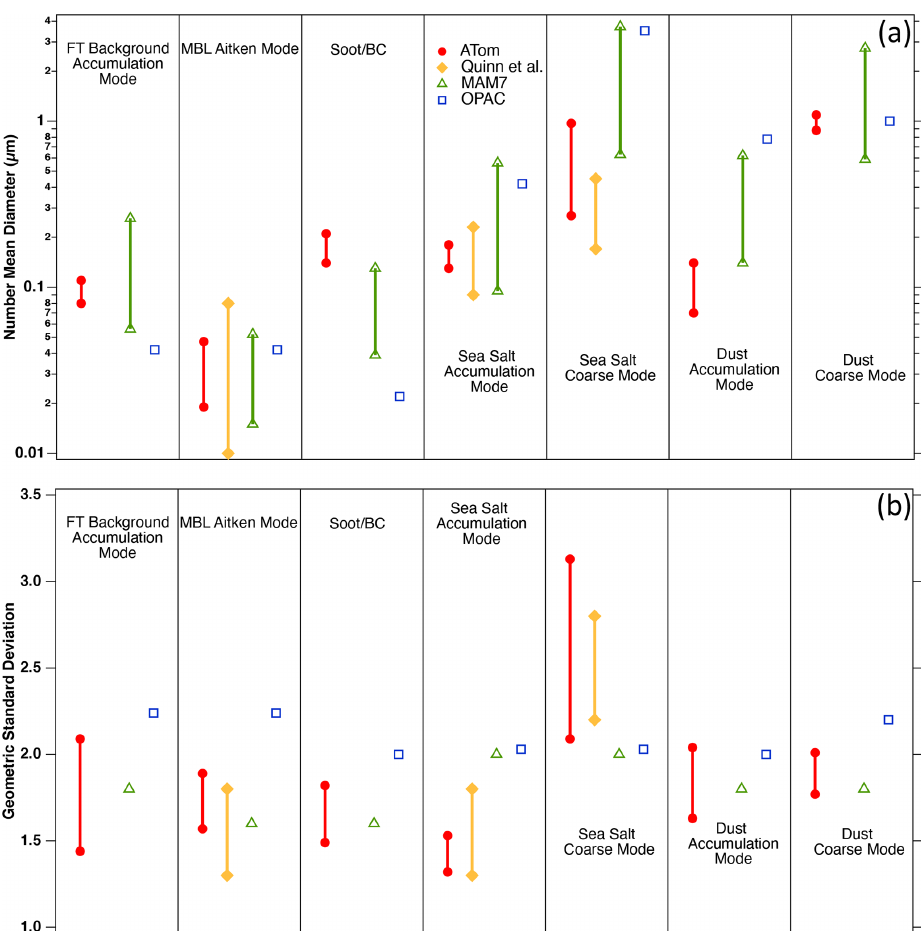
Figure 15. Lognormal parameters for different aerosol types from fits to the ATom dataset (showing interquartile range), from fits to shipboard size distribution measurements on the remote oceans (Quinn et al., 2017, showing full range), from the MAM7 modal aerosol model (Liu et al., 2012, 2016, showing interdecile range), and from the OPAC parameterization (Hess et al., 1998). (a) Number geometric mean diameter; (b) geometric standard deviation. The MAM7 parameterization provides a single fixed value of geometric standard deviation but a range of diameters for each aerosol